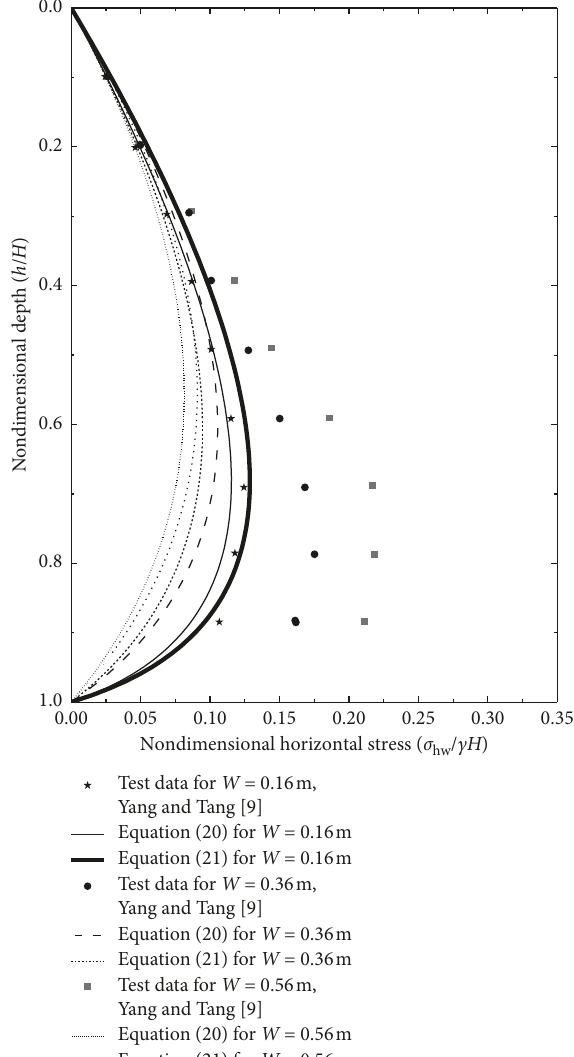
Figure 8: Calculated results of the attempted